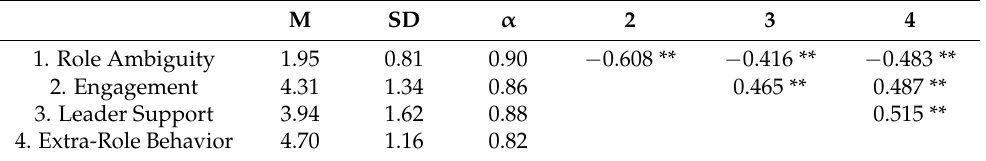
Table 2. Descriptive data, internal consistencies, and